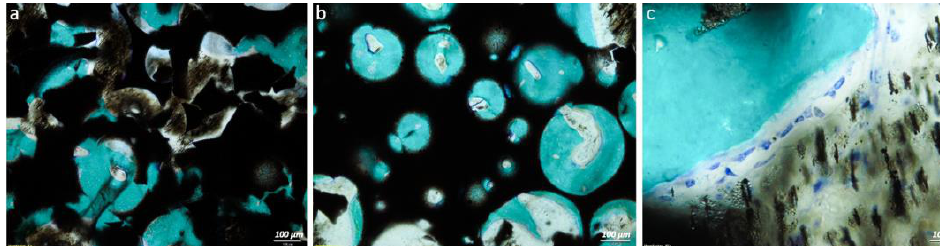
Figure 4. Histological images of resin-embedded samples from the magnetic scaffold + VEGF-MNPs treated group ( a , c ) and magnetic scaffold group ( b ) highlighting the growth of new bone filling the porosity of the scaffold and the regions in contact with it ( a , b ) and the presence of osteoblasts along bone trabeculae ( c ). Toluidine blue/fast green staining with 8× magnification — 100 μ m scale bar ( a , b ) and 80× magnification — 10 μ m scale bar ( c ).